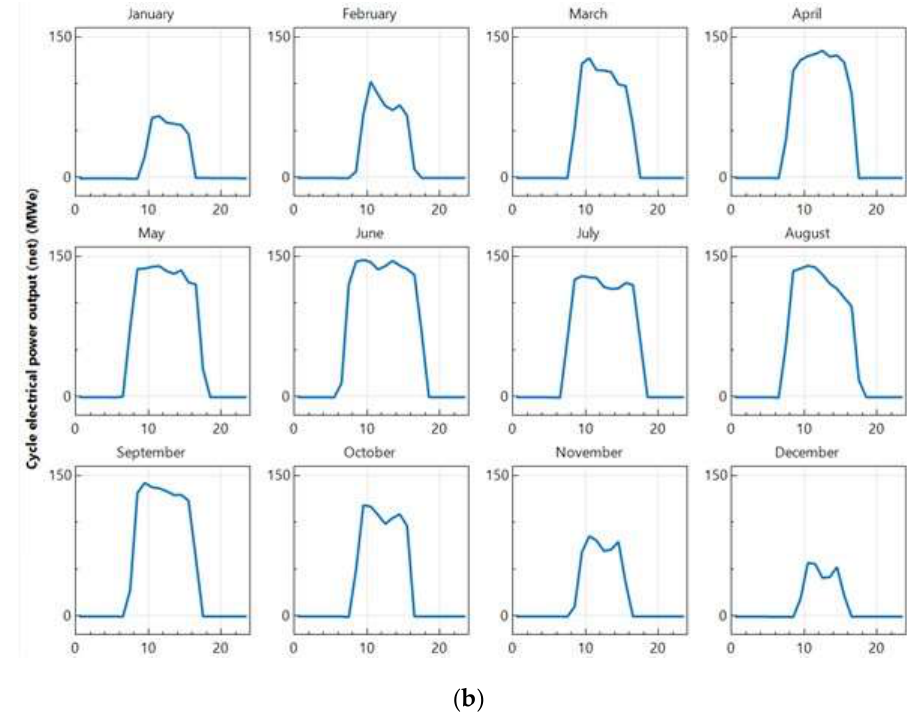
Figure 6. Mojave solar facility. ( a ) Computational thermal power produced by half the solar field and thermal power input to half the power cycle. ( b ) Computational net power output from one of the two turbines in the average day of every month. X is the time of the day in hours and Y the power in MW.